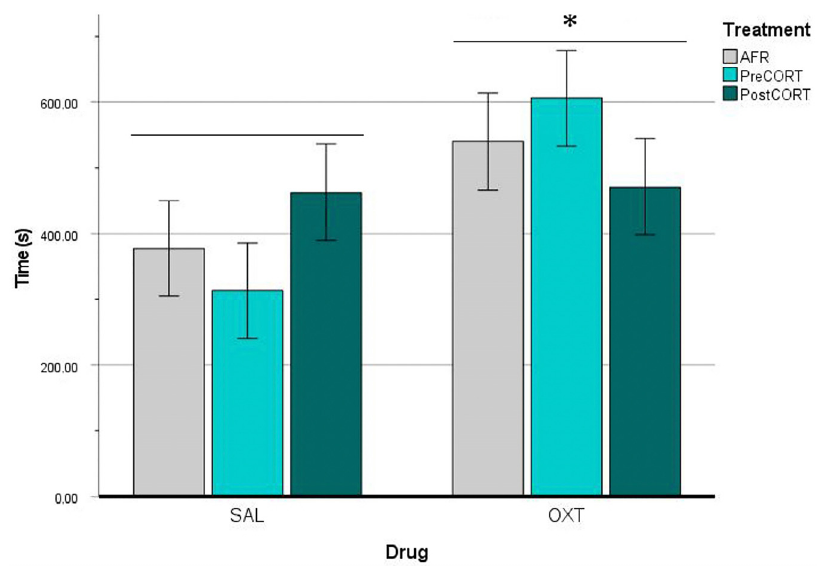
Figure 7. Self-grooming behaviour of Observer mice. Time spent by Observers ( n = 8 for each group) in self-grooming activity during the whole test. Regardless perinatal treatment, oxytocin administration globally, resulted in increased rates of self-grooming (* p < 0.05) during the emotional contagion assay. Error bars indicate mean ±